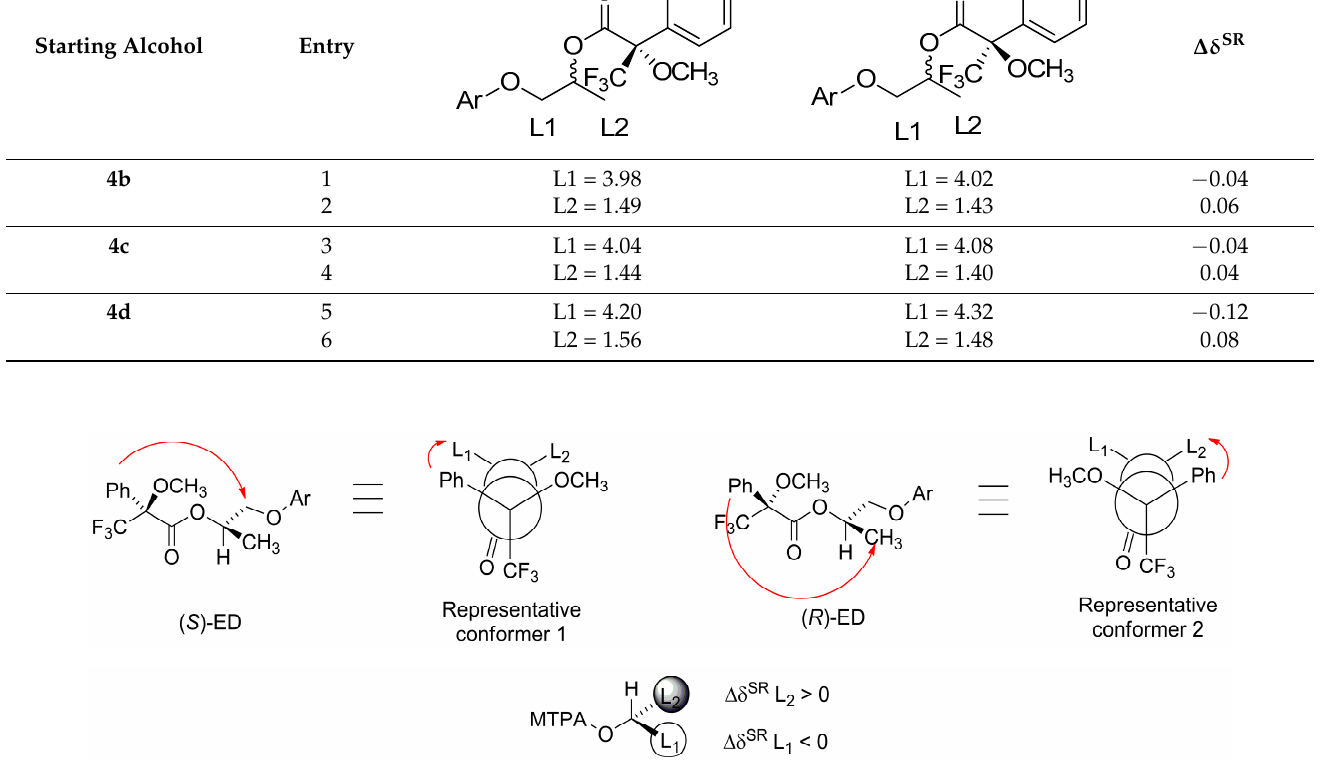
Figure 2. Mosher models [40] for the assignment of configurations of alcohols 4b-d by 1 H NMR using ∆δ SR .